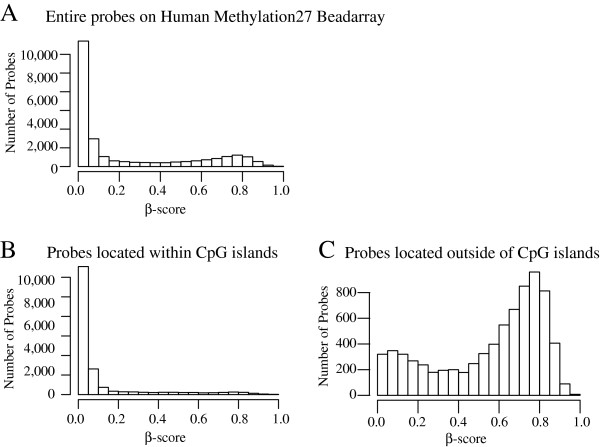
β-score distribution in the HumanMethylation27 BeadChip in the presence and absence of CpG islands in 1 randomly chosen sample. All samples display similar distributions as shown above. (A) The first histogram represents the β-score frequency of all probes. (B) The β-score frequency of the probes located within CpG islands is graphed. (C) The β-score frequency of the probes located outside of CpG islands is graphed.